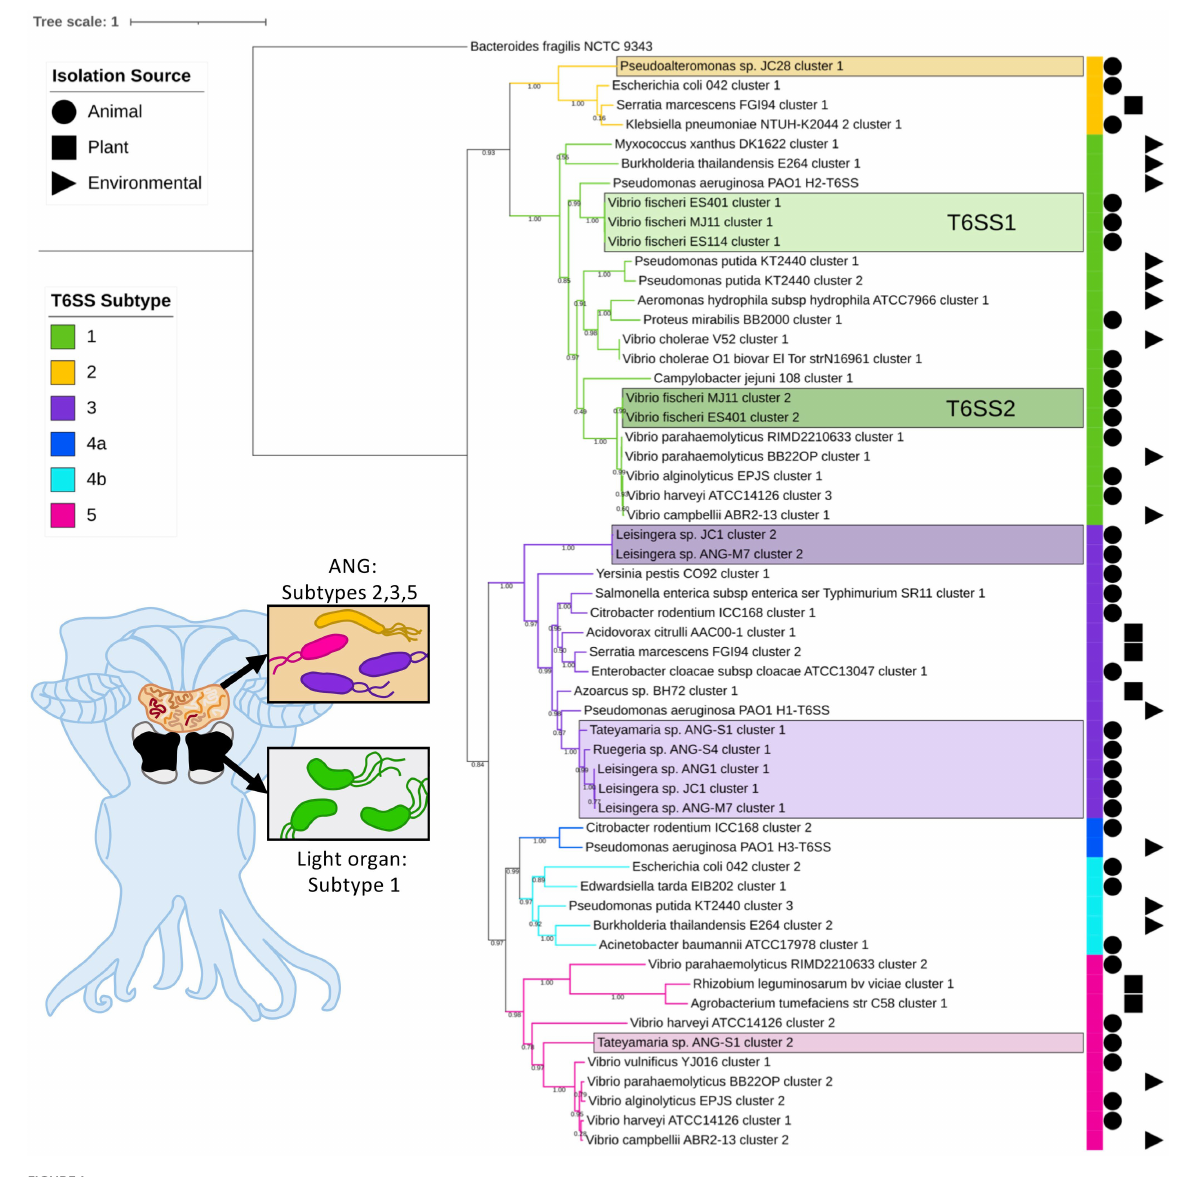
FIGURE 1 Maximum-likelihood phylogenetic tree of type VI secretion system (T6SS) sheath subunit proteins of Euprymna scolopes symbionts. A maximum- likelihood tree was constructed from the TssB and TssC small and large T6SS sheath subunit proteins predicted in select Euprymna scolopes accessory nidamental gland (ANG) and light organ bacterial symbiont genomes (names boxed) and reference genomes. The colored strip to the right of the tree and branch colors correspond to the T6SS subtype (Green = subtype 1, yellow = subtype 2, purple = subtype 3, dark blue = subtype 4a, light blue = subtype 4b, and pink = subtype 5). Symbols to the right of the colored strip indicate the isolation source of the sequenced bacterial strain (Circle = animal source, square = plant source, triangle = environmental source). Numbers on branches indicate bootstrap values. Inset cartoon diagram shows a ventral dissection of an adult female E. scolopes with colored ANG and light organ. Boxes show cartoon bacteria colored to represent the T6SS subtype of the symbionts found in each tissue type. See Supplementary Figure S1 for a complete phylogenetic tree with all strains analyzed in this